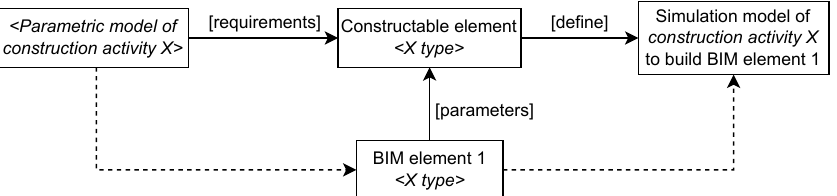
Figure 2. Constructable element